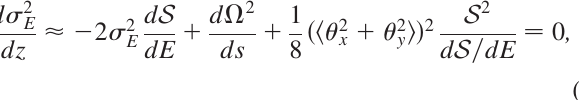
FIG. 5. Kinetic energy histogram for a broad energy distribu- tion of antiprotons after a frictional cooling section with 150 carbon foils each 20 nm thick and a total potential of 109 kV. A value of (cid:10) (cid:9) ¼ 0 : 05 was used. The equilibrium energy is about 5 keV, with an rms energy spread of about 0.6 keV and < 2% overall losses. For comparison we also show (solid line) the Gaussian fit based on a continuous medium